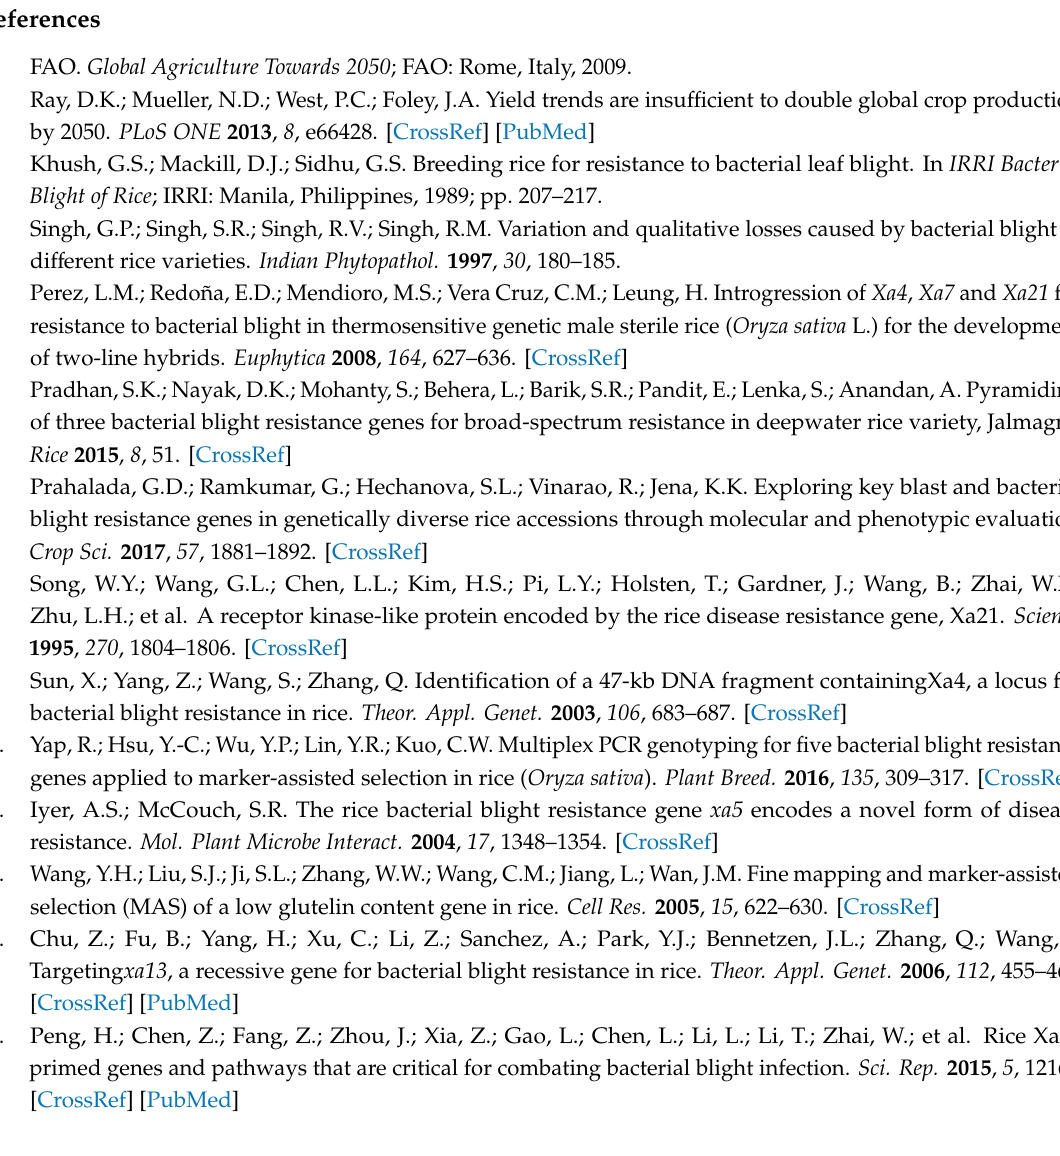
Figure S1: The polymorphic markers used for background selection of TNG82 / IRBB66 backcross population. Table S1: The genome composition of BC 2 F 2 derived from TNG82 / IRBB66 by 117 polymorphic markers used for